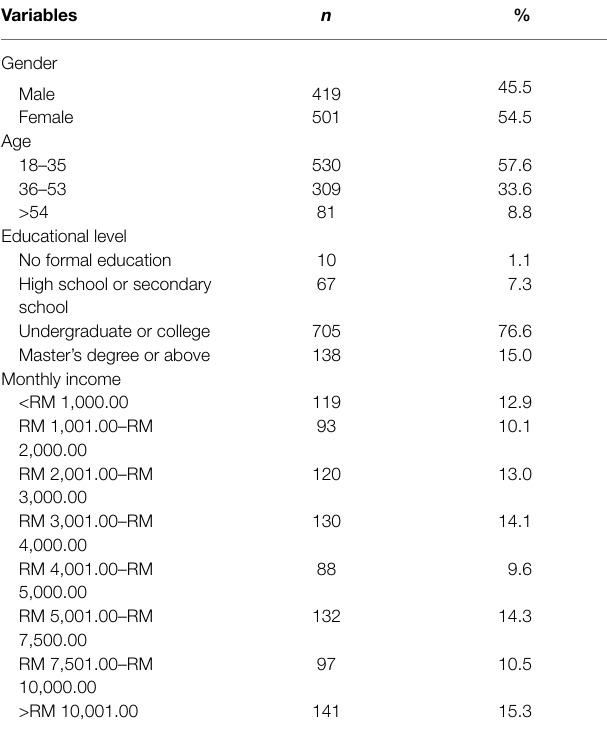
TABLE 1 | Demographic characteristics of the participants ( n =